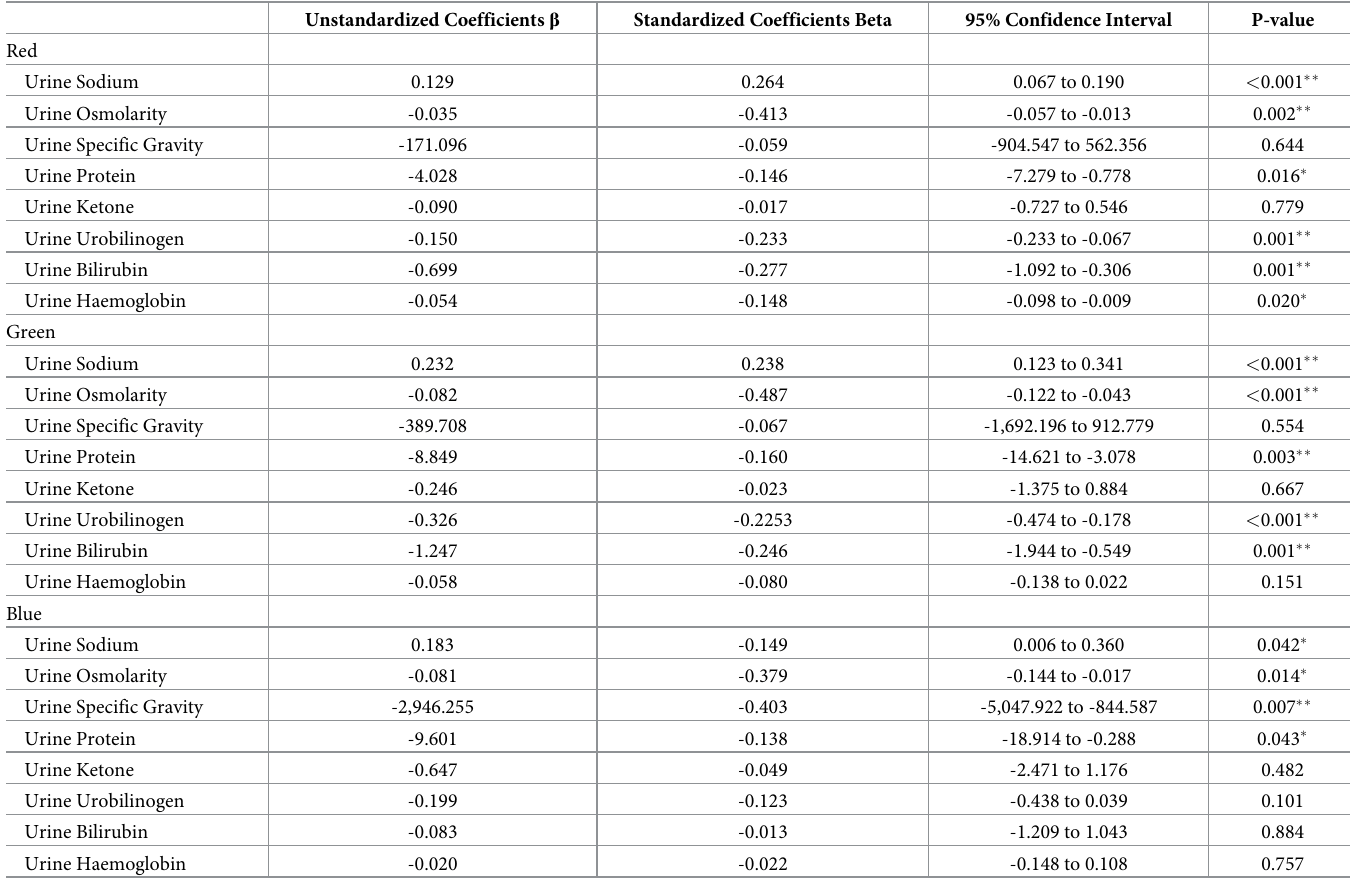
Table 4. Association of RGB urine colour values with biochemical characteristics of urine analysis using multiple linear